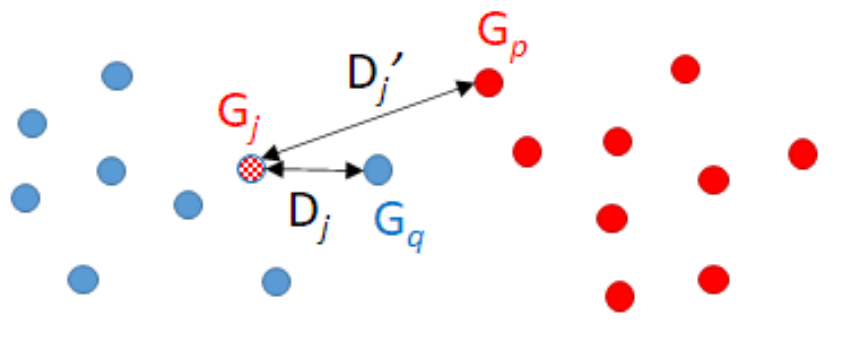
Figure 3. Classification of molecule G j . The true classes are in solid colours. G j is classified in the wrong class (blue), but the correct class is the red one. The distance between G j and G q is lower than the distance between G j and G p